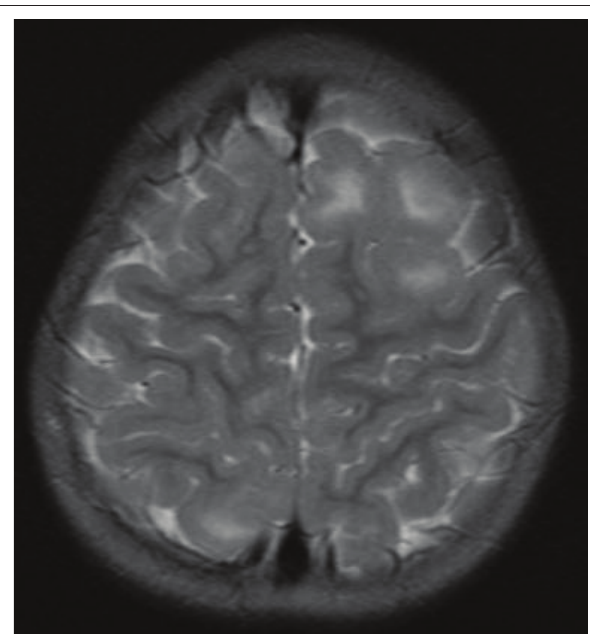
FIGURE 1: Axial T2-weighted MR image.